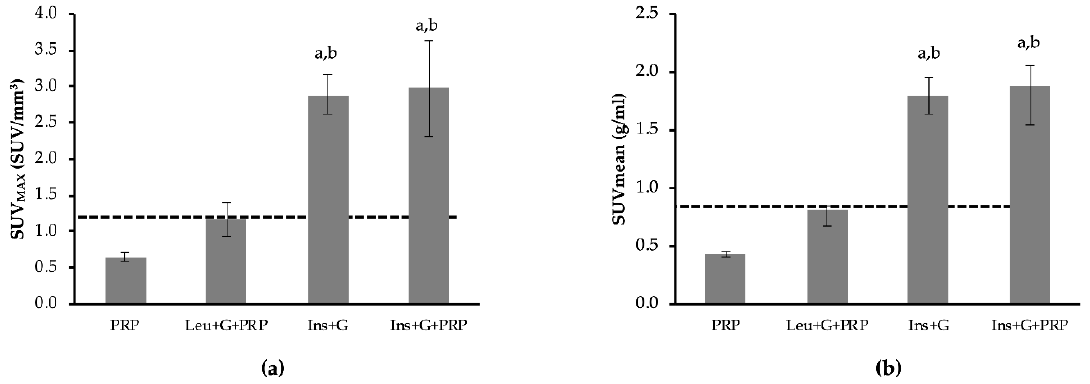
Figure 4. The e ff ect of inhibiting β -adrenergic activation on 2-deoxy-2-(fluorine-18)fluoro- d -glucose ( 18 F-FDG) uptake in the heart. β -adrenergic activation was inhibited by pretreatment with propranolol (PRP). Dashed line represents SUV MAX for control / untreated animals. Following pretreatment with PRP, mice were either untreated (PRP), or treated with leucine and glucose (Leu + G + PRP) or insulin and glucose (Ins + G + PRP). SUV is also reported for insulin and glucose together, without PRP (Ins + G). ( a ) Group mean data for the maximum SUV (SUV MAX , units in SUV / mm 3 ) was calculated for the heart for each treatment group. ( b ) Group mean data for the average SUV across the entire tissue (SUVmean, units in g / mL). Data are expressed as mean ± the SEM. A one-way analysis of variance was performed followed by a Fisher LSD post-hoc. a, denotes significant di ff erence compared to PRP; b, denotes significant di ff erence compared to Leu + G + PRP ( p ≤ 0.05). n = 3–4, if tissue was not visible in scan image, it was excluded.